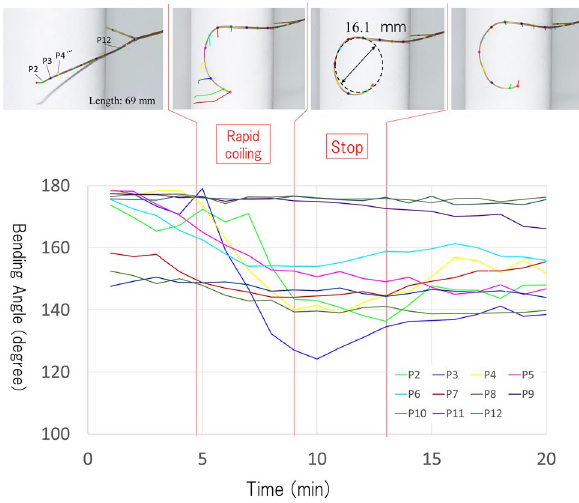
Figure 6. 3D motion tracking of the tendril coiling on thick support. Tendril of 69 mm length was placed in contact with 40 mm diameter rod. As in Fig. 5, after the region where the angle changes rapidly (transform stage), the region with almost no change (stop stage) appears. The coiling diameter in stop stage that was calculated from the 3D coordinates of the markers was about 16.1